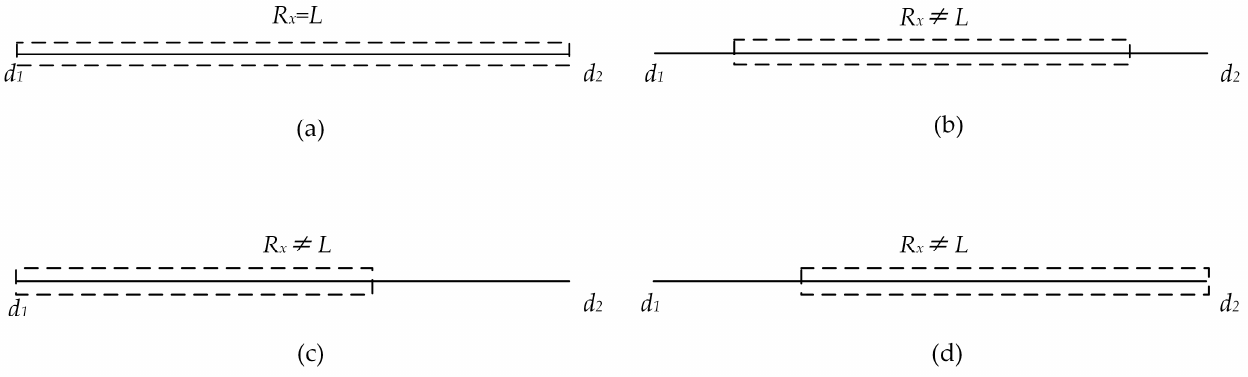
Figure 1. Different cases of building the index from coarse to fine-grained. ( a ) the index value covers the middle position of the interval. ( b ) the index value covers the middle position of the interval. ( c ) the coverage of the index value starts at the starting position d 1 . ( d ) the coverage of the index value ends at the endpoint d 2 .